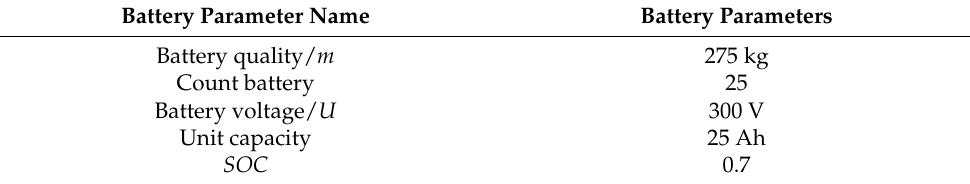
Table 6. Battery